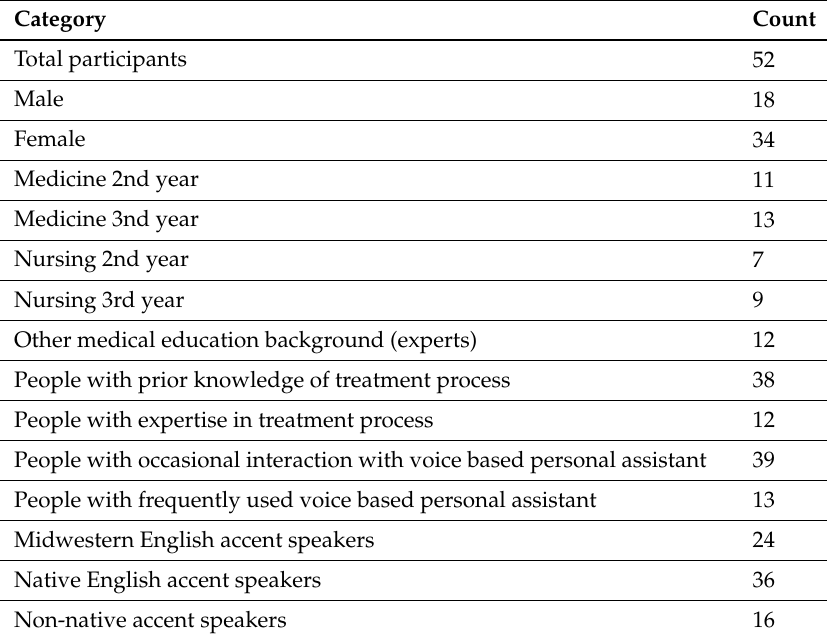
Table 2. Participant distribution